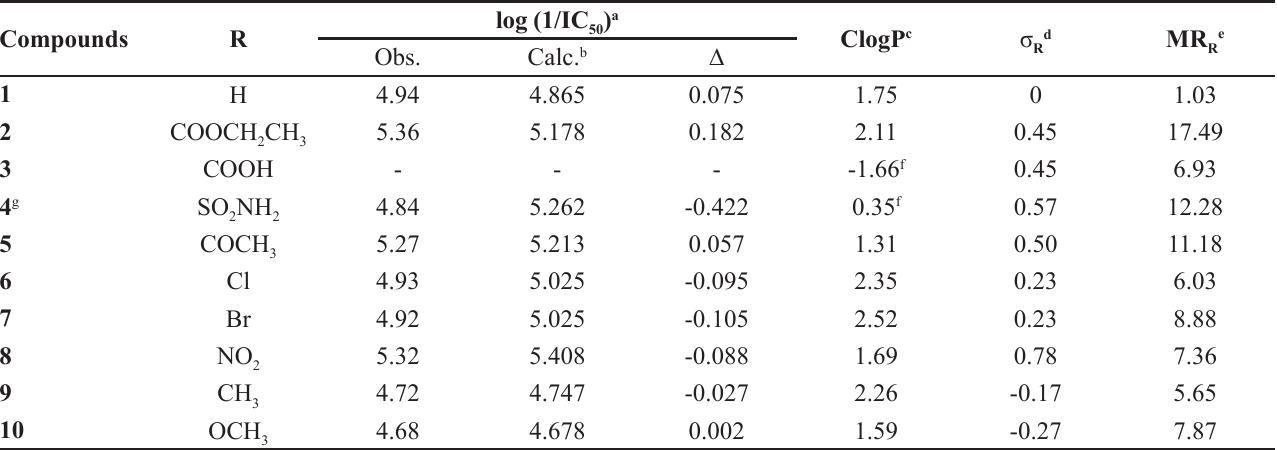
TABLE II - Physicochemical parameters and observed and calculated biological activity